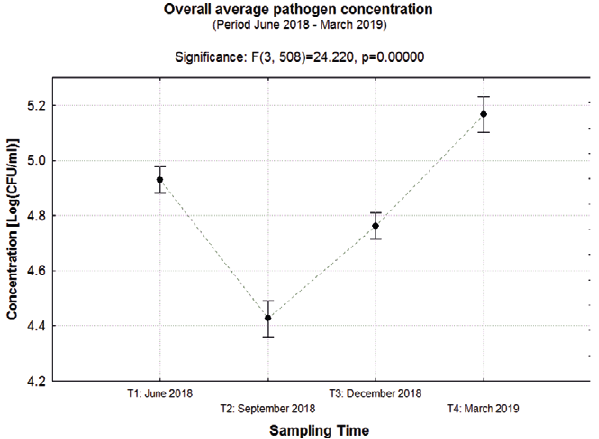
Figure 7. General trend of mean Xylella fastidiosa concentrations in two olive cultivars at four sampling times (T1 to T4) during 2018/19.